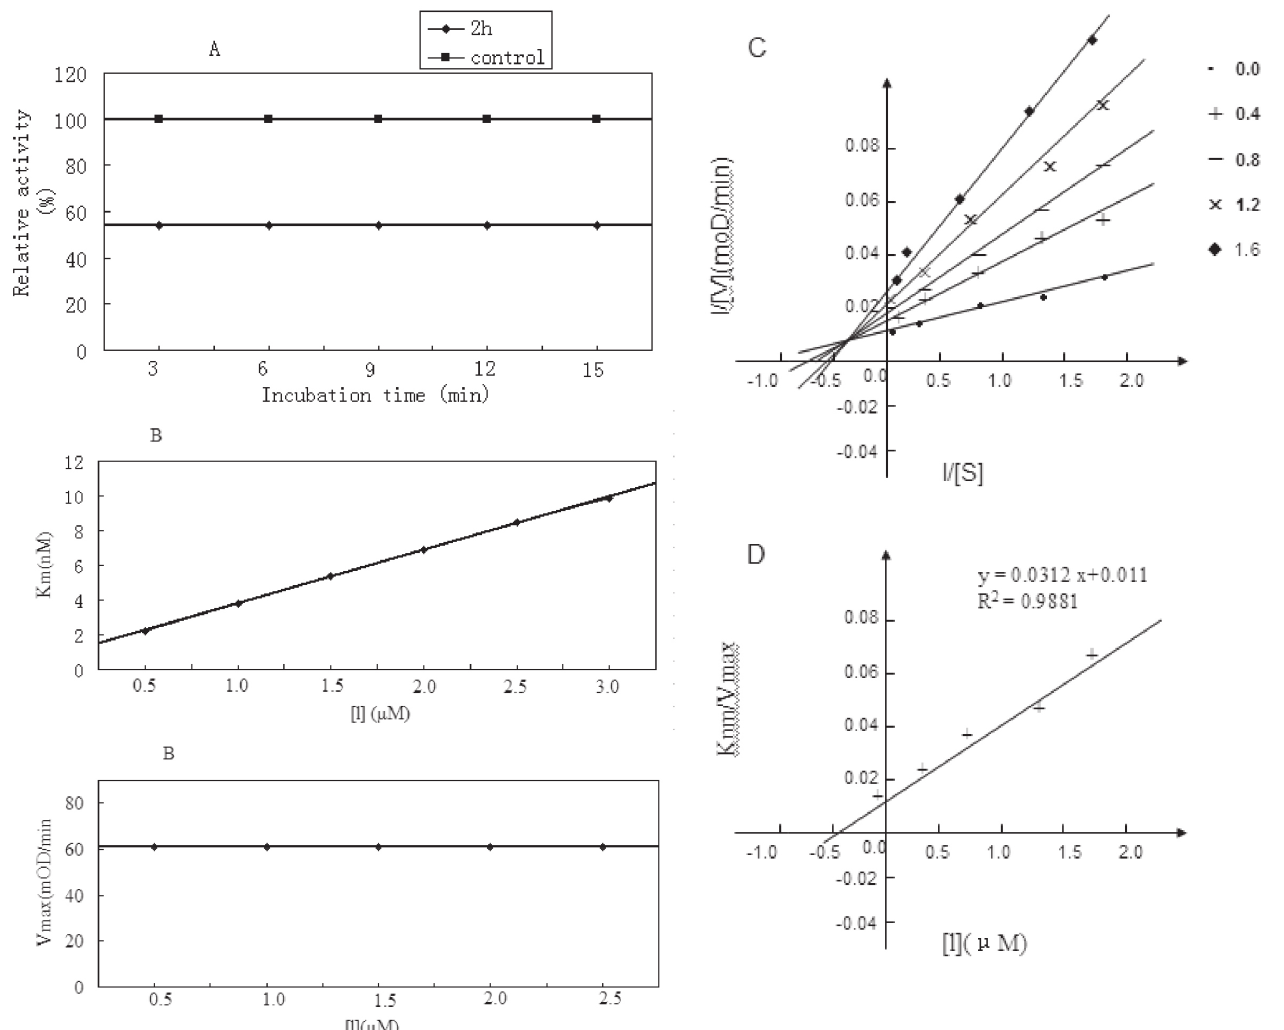
FIGURE 2 - Characterization of the inhibitory mechanism of compound 2h toward PTP1B. (A) The time-independent inhibition of PTP1B by 2h ; (B) At various fixed concentrations of 2h the initial velocity was determined with various concentrations of p NPP; (C) The mixed inhibition of 2h shown by Lineweaver–Burk plot; (D) K TABLE II - The antitumor activity of compound 2h in vitro a